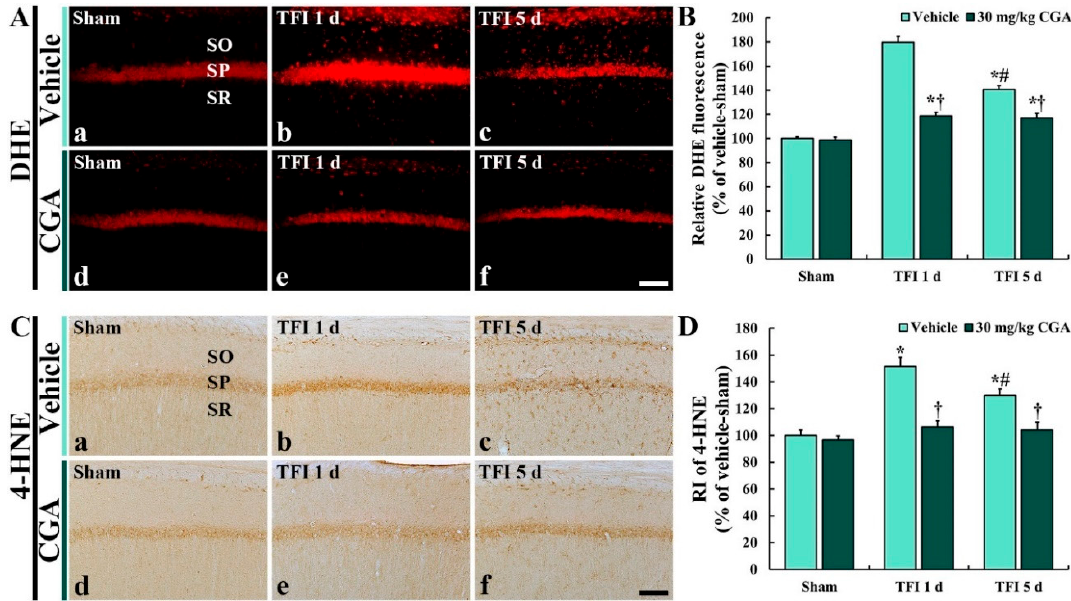
Figure 4. Dihydroethidium (DHE) histofluorescence ( A ) and 4-HNE immunohistochemistry ( B ) of the vehicle/sham ( A ( a ), C ( a )), CGA/sham ( A ( d ), C ( d )), vehicle/TFI ( A ( b , c ), C ( c , d )) and CGA/TFI ( A ( e , f ), C ( e , f )) groups at 1 and 5 days after TFI. DHE fluorescence and 4-HNE immunoreactivity in the vehicle/sham group are shown in CA1 pyramidal cells located in the SP. DHE fluorescence and 4-HNE immunoreactivity in CA1 pyramidal cells of the vehicle/TFI group are markedly enhanced after TFI, but CGA treatment apparently reduces their levels after TFI. SO, stratum oriens; SP, stratum pyramidale; SR, stratum radiatum. Scale bar = 40 μ m. C and D: relative fluorescence of DHE ( C ) and relative immunoreactivity (RI) of 4-HNE ( D ) in the CA1 SP. The bars indicate the means ± SEM ( n = 7 at each point in time, * p < 0.05 vs. the vehicle/sham group, † p < 0.05 vs. the corresponding time point vehicle group, # p < 0.05 vs. the pretime point vehicle/TFI group).